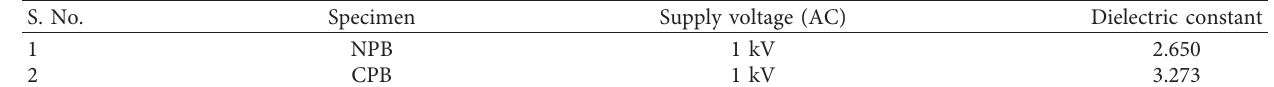
Table 1: Dielectric constant of specimens (NPB and CPB).